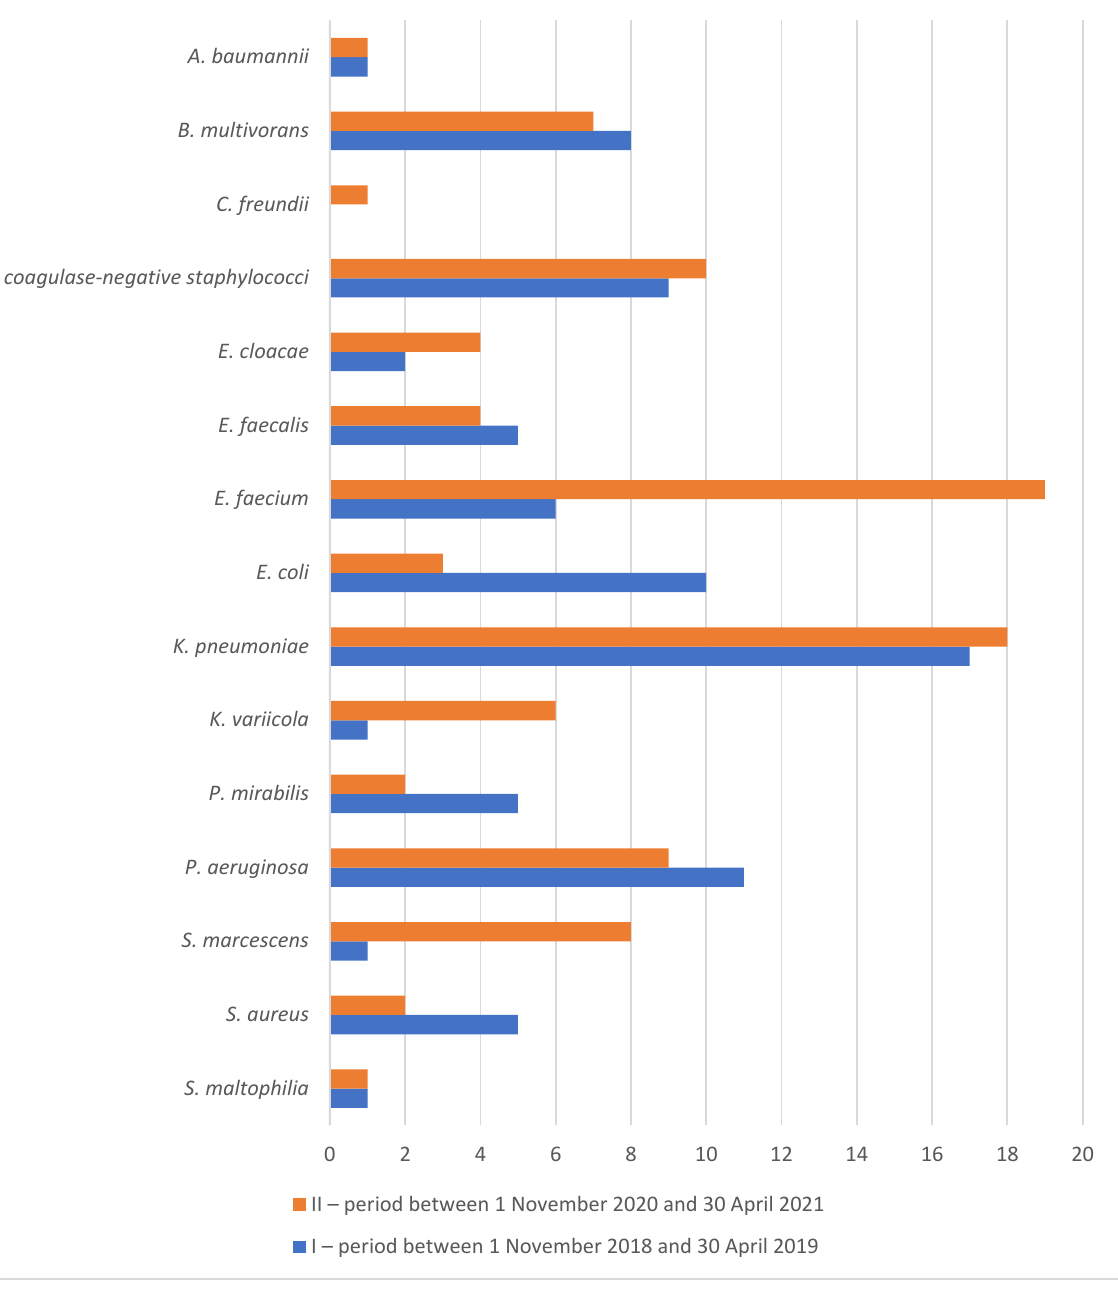
Figure 2. Percentage of species from total number of etiological agents isolated from blood stream, lower respiratory tract and urine in the Department of Anesthesiology, Resuscitation and Intensive Care before (I) and during (II) the COVID-19 pandemic. Table 3 documents the resistance of bacterial pathogens to antibiotics before and dur- ing the COVID-19 pandemic. The results show that some species considerably increased their resistance during the pandemic. Serratia marcescens increased its resistance to third- and fourth-generation cephalosporins (cefotaxime, ceftazidime, cefepime) from 14%, 0%, respectively, to 70% as well as to ciprofloxacin (from 0% to 67%), gentamicin (from 0% to 69%), tigecycline (from 14% to 100%) and co-trimoxazole (from 0% to 71%). A significant increase in resistance to third-generation cephalosporins and piperacillin/tazobactam was also noted in Enterobacter cloacae (from 33% to 68%). Stenotrophomonas maltophilia increased its resistance significantly to ciprofloxacin (from 70% to 100%).